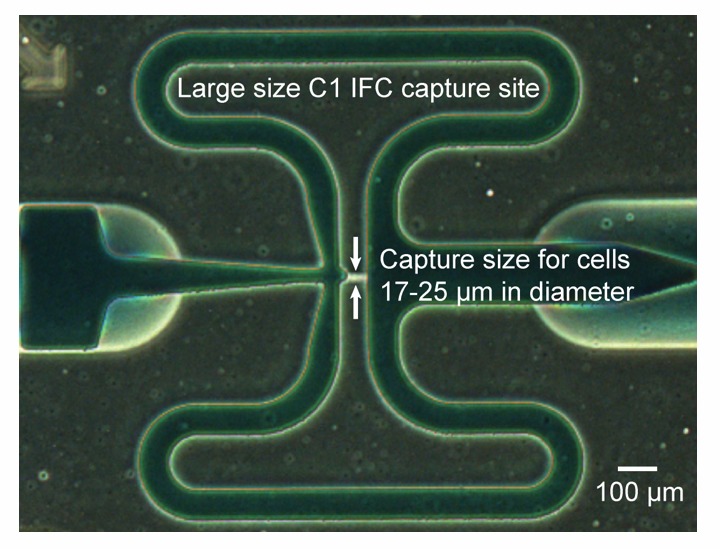
DOI:
http://dx.doi.org/10.7554/eLife.26580.025